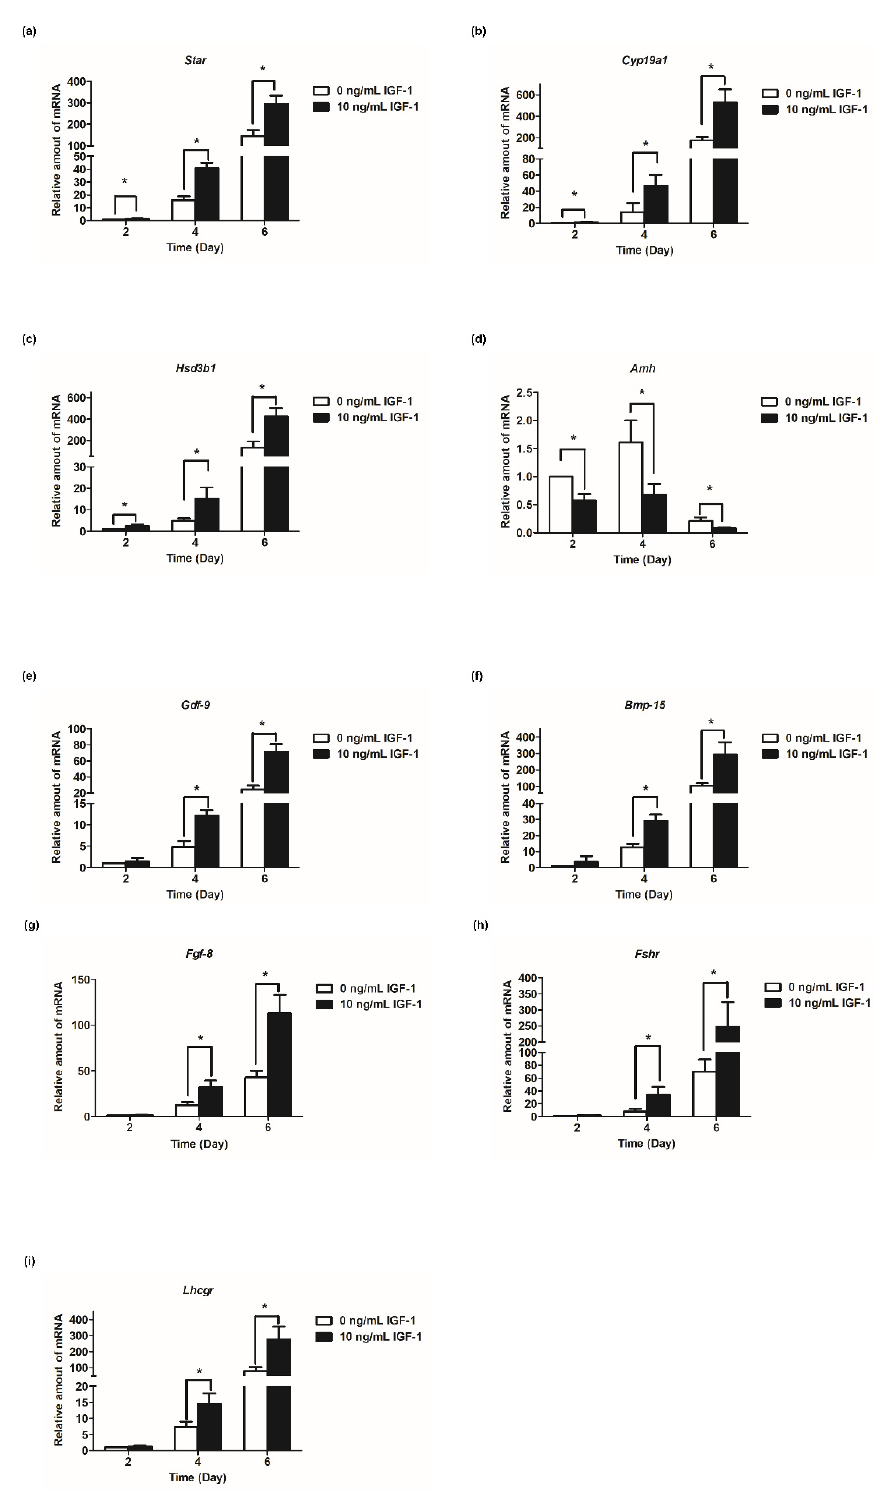
Figure 4. Effect of IGF-1 on the mRNA expression of hormone secretion related genes, oocyte- secreted factors and gonadotropin receptors in vitro. ( a ) The mRNA expression of Star ; ( b ) The mRNA expression of Cyp19a1 ; ( c ) The mRNA expression of Hsd3b1 ; ( d ) The mRNA expression of Amh ; ( e ) The mRNA expression of Gdf-9 ; ( f ) The mRNA expression of Bmp-15 ; ( g ) The mRNA expression of Fgf-8 ; ( h ) The mRNA expression of Fshr ; and ( i ) The mRNA expression of Lhcgr . * p < 0.05 compared to the control group; error bar: standard deviation. n = 10 follicles for each of three replicates.